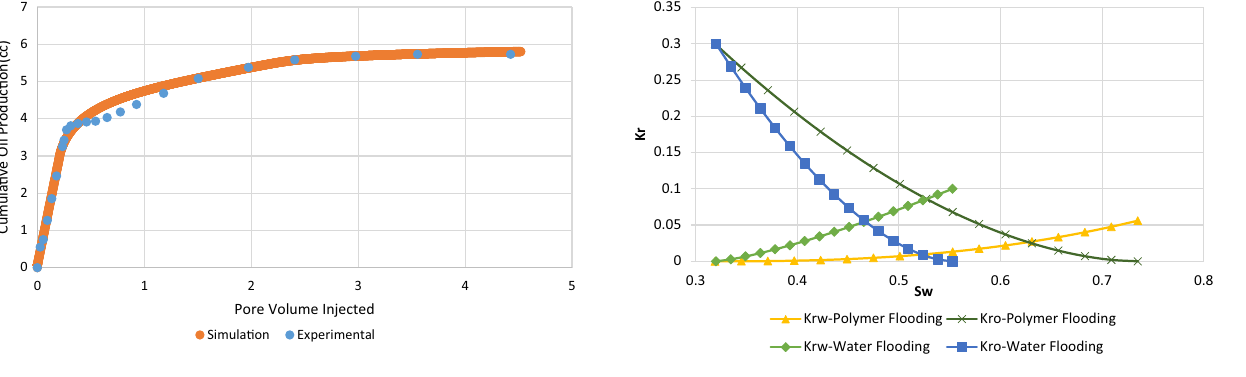
Fig. 14 History matching of cumulative oil production during poly- mer flooding